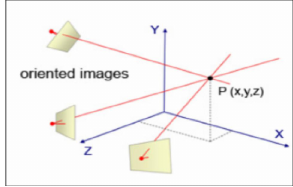
Figure 1. The principle of close-range photogrammetry (Koch & Kaehler, 2009)